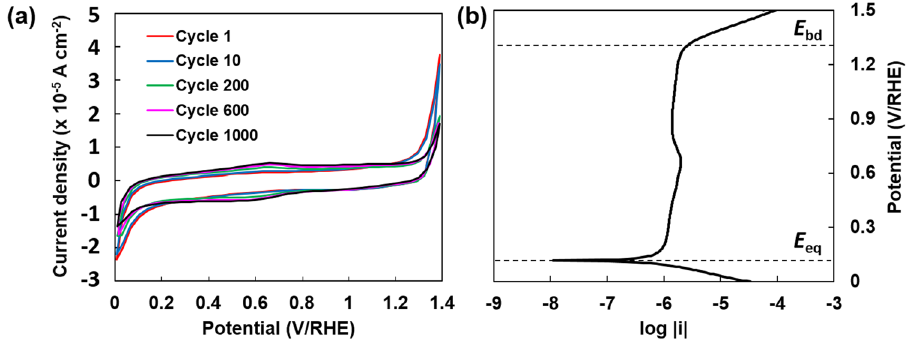
Figure 6. ( a ) Cyclic voltammogram of heat-treated TiO x -A in oxygen-saturated HCl 1 M solution between 0 and 1.4 V/RHE at a potential sweep of 50 mV/s. The voltammogram shape did not significantly change after 1000 cycles, especially in the pseudocapacitive region. ( b ) Potentiodynamic curve of heat-treated TiO x -A in oxygen-saturated HCl 1 M solution between 0 and 1.5 V/RHE. The curve shows a tendency of TiO x -A to passivate with a high break-down